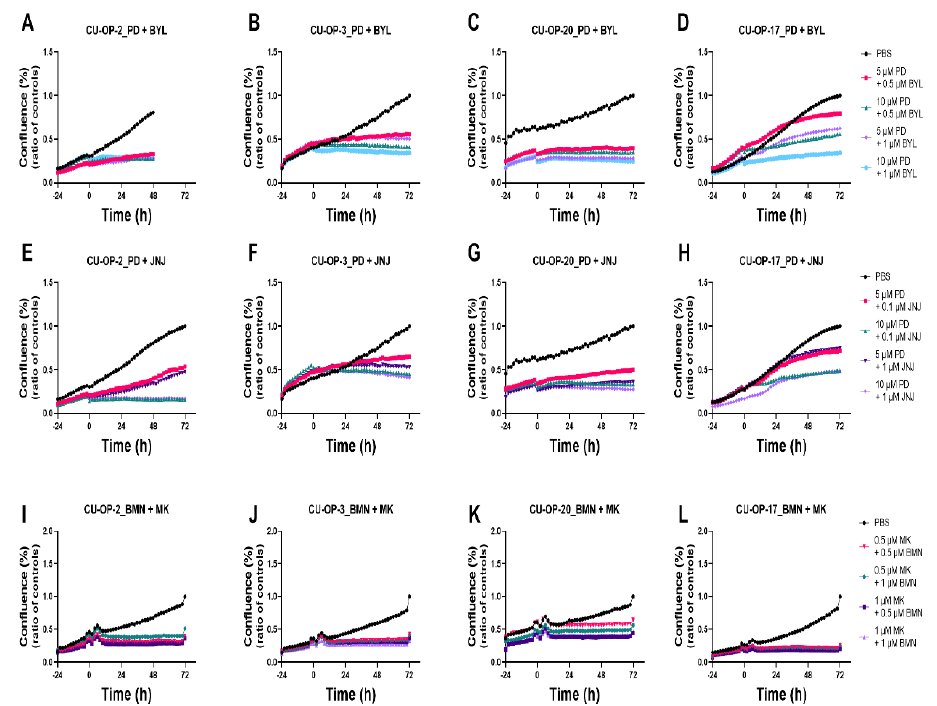
Figure 8. Proliferation response of HPV + CU-OP-2, CU-OP-3, CU-OP-20, and HPV − CU-OP-17 cell lines upon combined treatment with PD-0332991 and BYL719 or JNJ-42756493. Proliferation responses of HPV + CU-OP-2, CU-OP-3, CU-OP-20, and HPV − CU-OP-17 after treatment with CDK4/6 inhibitor PD-0332991 and PI3K inhibitor BYL719 ( A – D ) or with FGFR inhibitor JNJ-42756493 ( E – H ), or with the PARP inhibitor BMN-673 and WEE1 inhibitor MK-1775 ( I – L ). The graphs represent one experimental run per cell line. Confluence (%) denotes proliferation response; PD denotes PD-033299; BYL denotes BYL719; JNJ denotes JNJ-4275649; BMN denotes BMN-673; and MK denotes MK-1775.